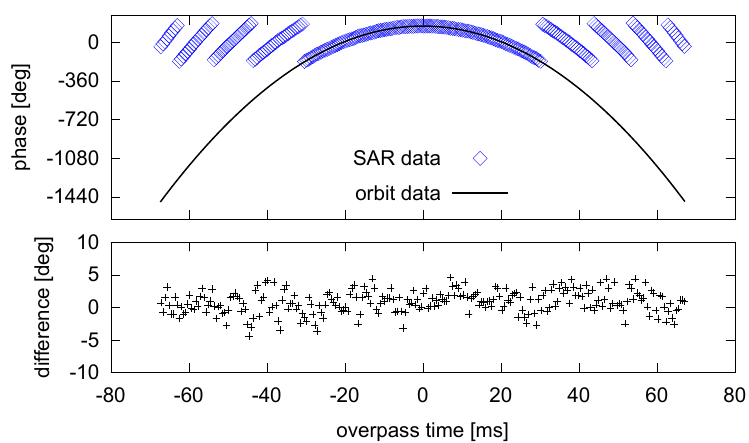
Figure 3. Point target phase φ ( top ) derived from SAR data (detected phase in blue) acquired on 25 August 2016 and predicted phase from geometry (black line); resulting phase differences after unwrapping the SAR data phase ( bottom ). Each (blue) pixel represents the phase of the target response (at the amplitude peak within the range line) from an individual pulse received by the SAR instrument. The amplitude of azimuth compressed data as a function of the azimuth offset is depicted in Figure 4. A maximum value on the x -axis origin indicates that the measured phase (from L0 data) matches with the predicted geometry from orbit data as seen for precise orbit (solid line). An azimuth shift occurs if the measured and predicted phases are shifted in time relative to each other. This could be caused by an inaccurate geometry (orbit or target) or imprecise timing information. Using a predicted orbit, which was available before the acquisition has been acquired, an azimuth offset of 4.8 m remains (dashed line in Figure 4). This offset corresponds to an orbit shift in time of about 700 µ s. In contrast to the well balanced case depicted in Figure 3 (bottom), the predicted orbit introduces a remaining linear phase ramp in this case. The matched filter output from azimuth is complex interpolated to improve the resolution and thus to increase the accuracy of the azimuth offset result derived for each dataset.